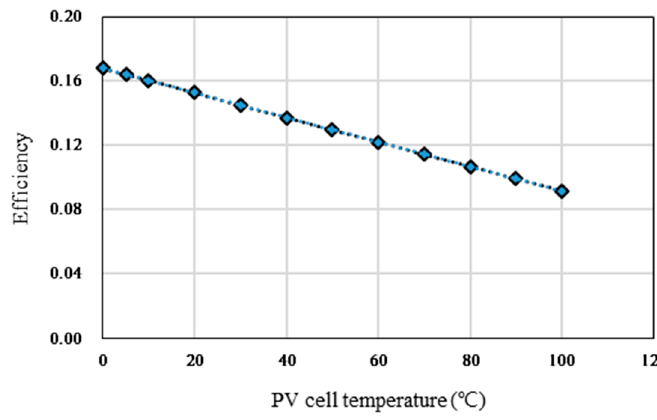
Figure 5. Efficiency of PV cell as a function of the cell temperature at a 350 W/m 2